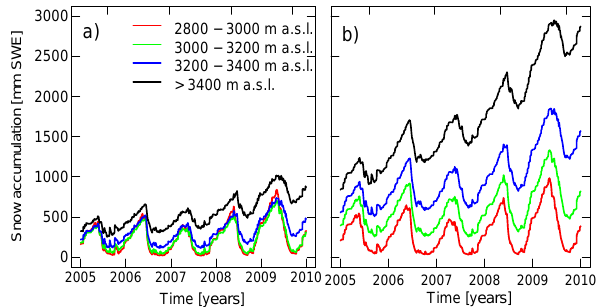
Figure 10. Behaviour of snow accumulation and melt of model A (a) and B (b) in the upper elevations. Note that model results are shown from 2005 to 2010 without the warm-up period for clarity reasons. Therefore, snow depth does not start at zero in the figure while it does at the beginning of the modelling.